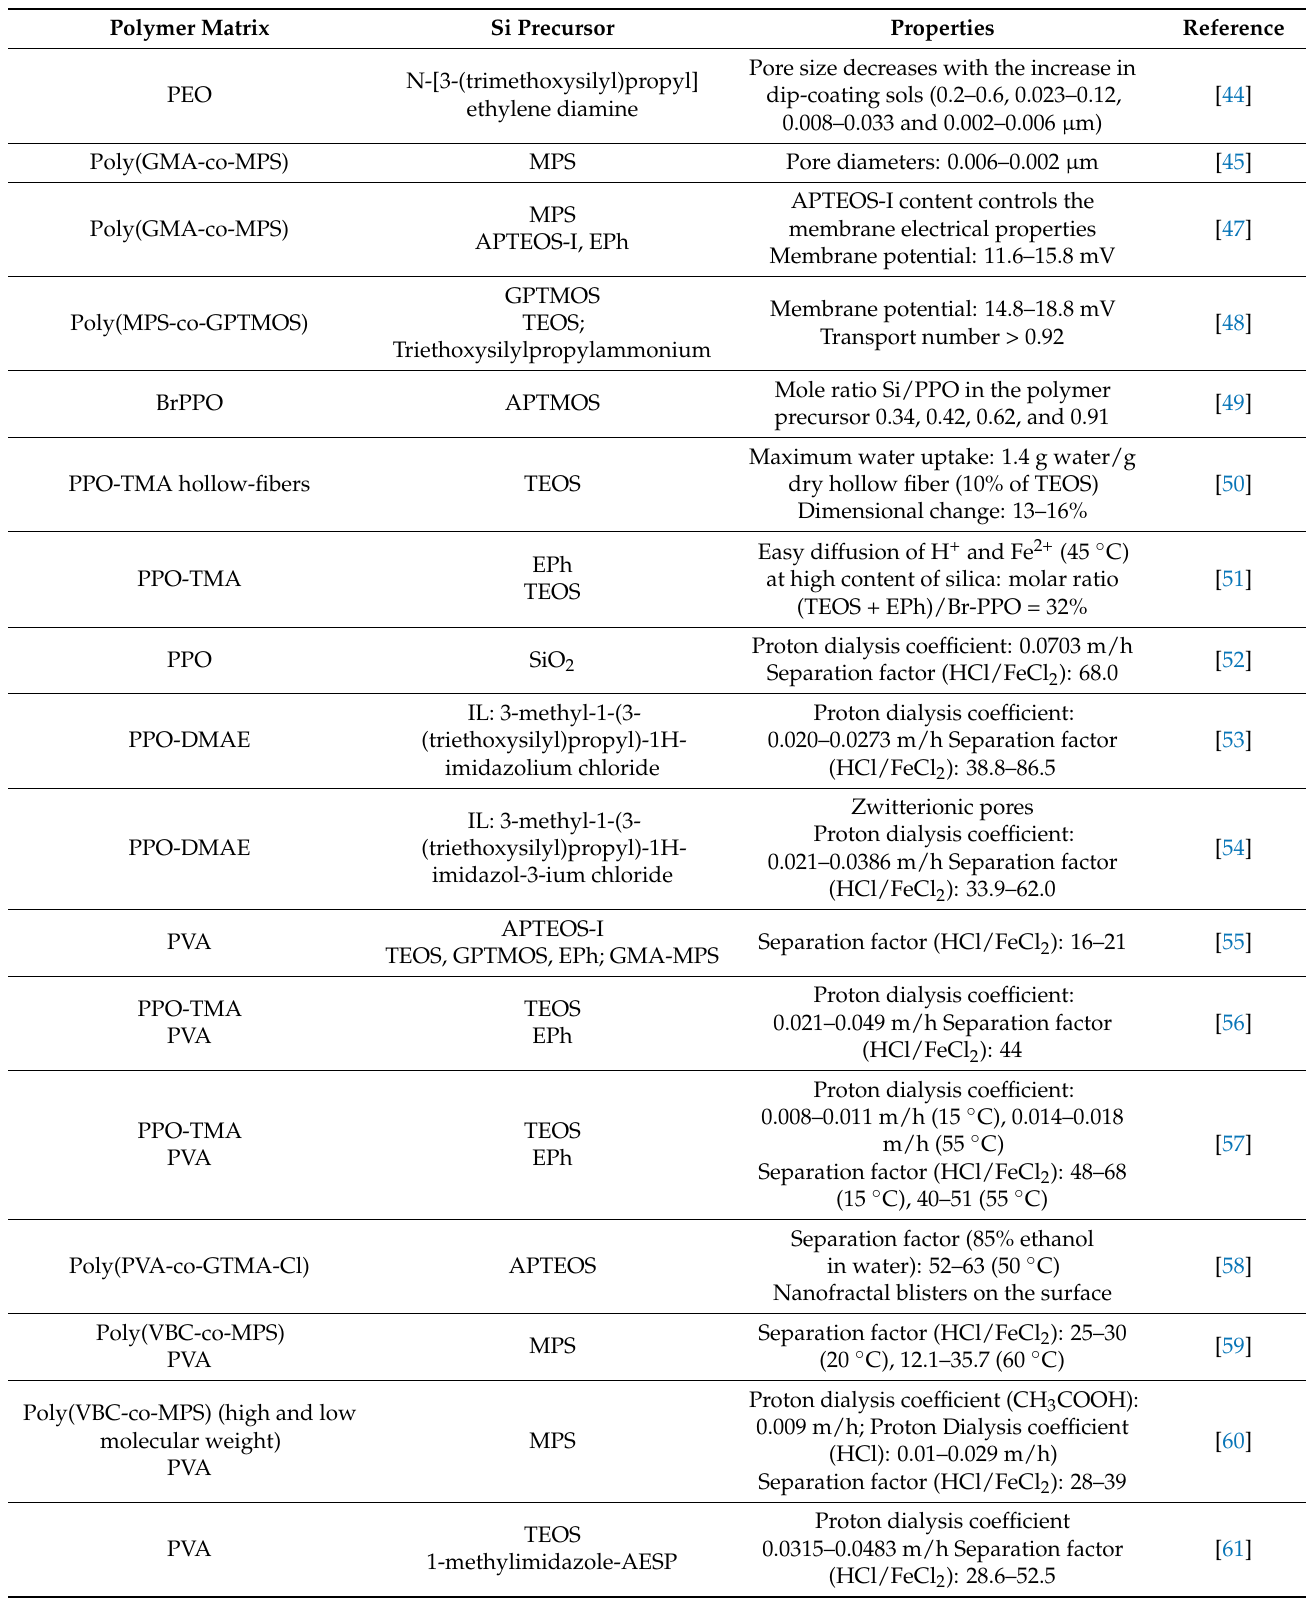
Table 1. Polymer precursors, Si sources, and important properties of sol–gel modified